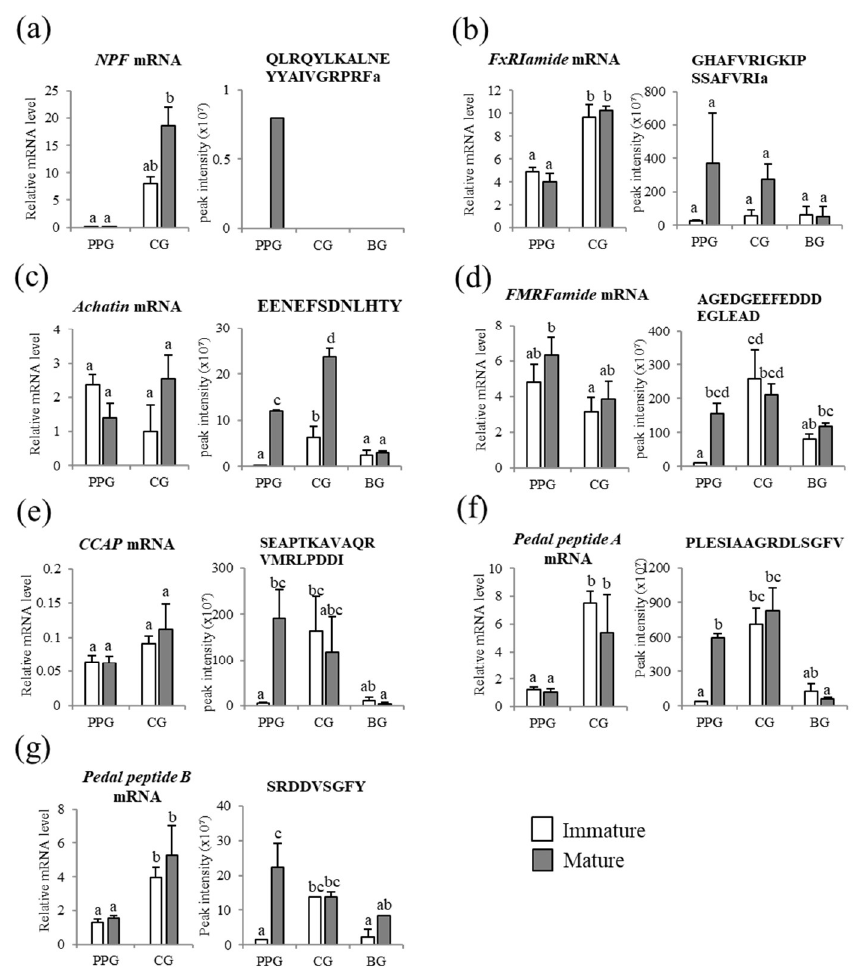
Figure 6. Quantitative comparisons of mRNAs of neuropeptide precursors and neuropeptides in the ganglia PPG, CG, and BG between immature and mature Haliotis discus hannai . ( a ) NPF; ( b ) FxRIamide; ( c ) Achatin; ( d ) FMRFamide; ( e ) crustacean cardioactive peptide (CCAP); ( f ) Pedal peptide A; and, ( g ) Pedal peptide B. The histograms on the left are mean mRNA expression levels of neuropeptide precursors determined by qPCR ( n = 4), and the histograms on the right are mean peak intensity of their representative individual neuropeptides ( n = 3; Table S7). Data are means ± SEM. Means were compared by two-way ANOVA, followed by Bonferroni’s post-hoc test (SPSS version 23, SPSS). Different lowercase letters (a, b and c) on the bars indicate significant differences ( p < 0.05).